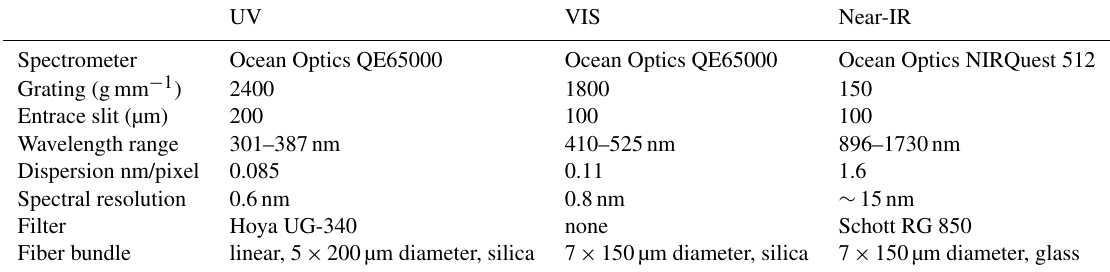
Table 2. Spectral characteristics of the mini-DOAS